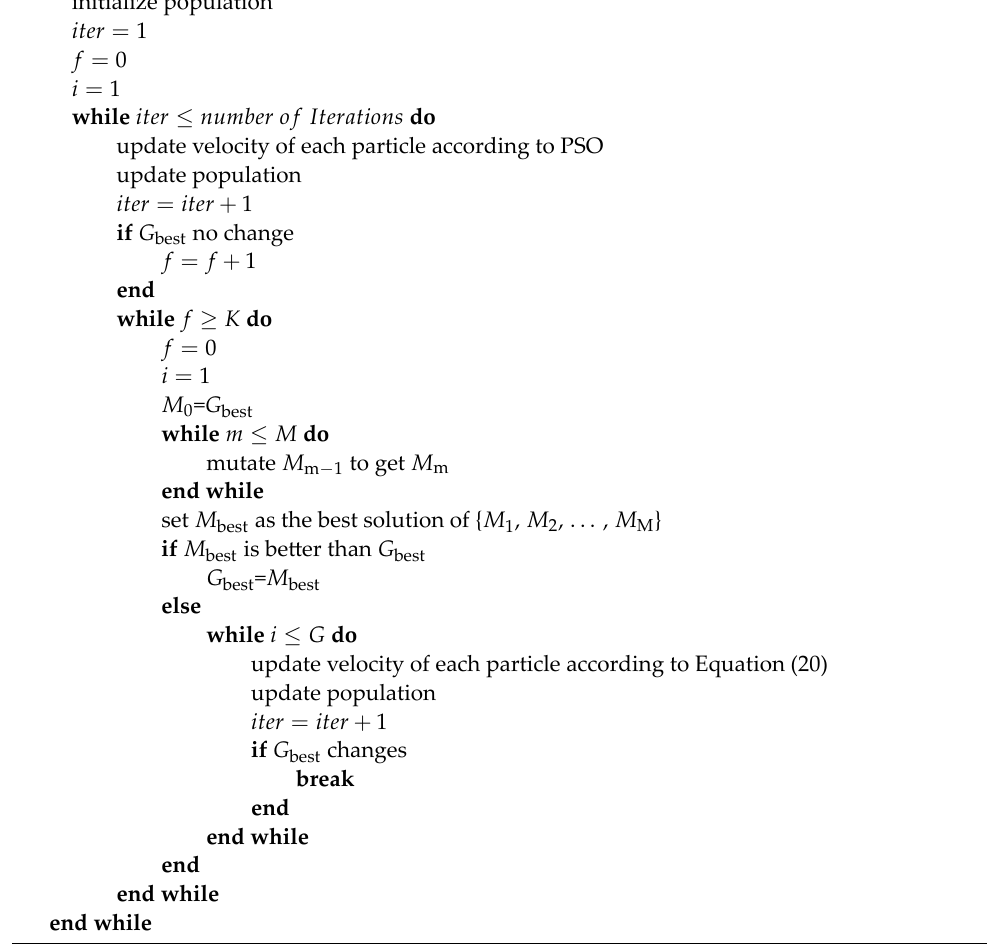
Algorithm 3. Improved particle swarm optimization pseudo